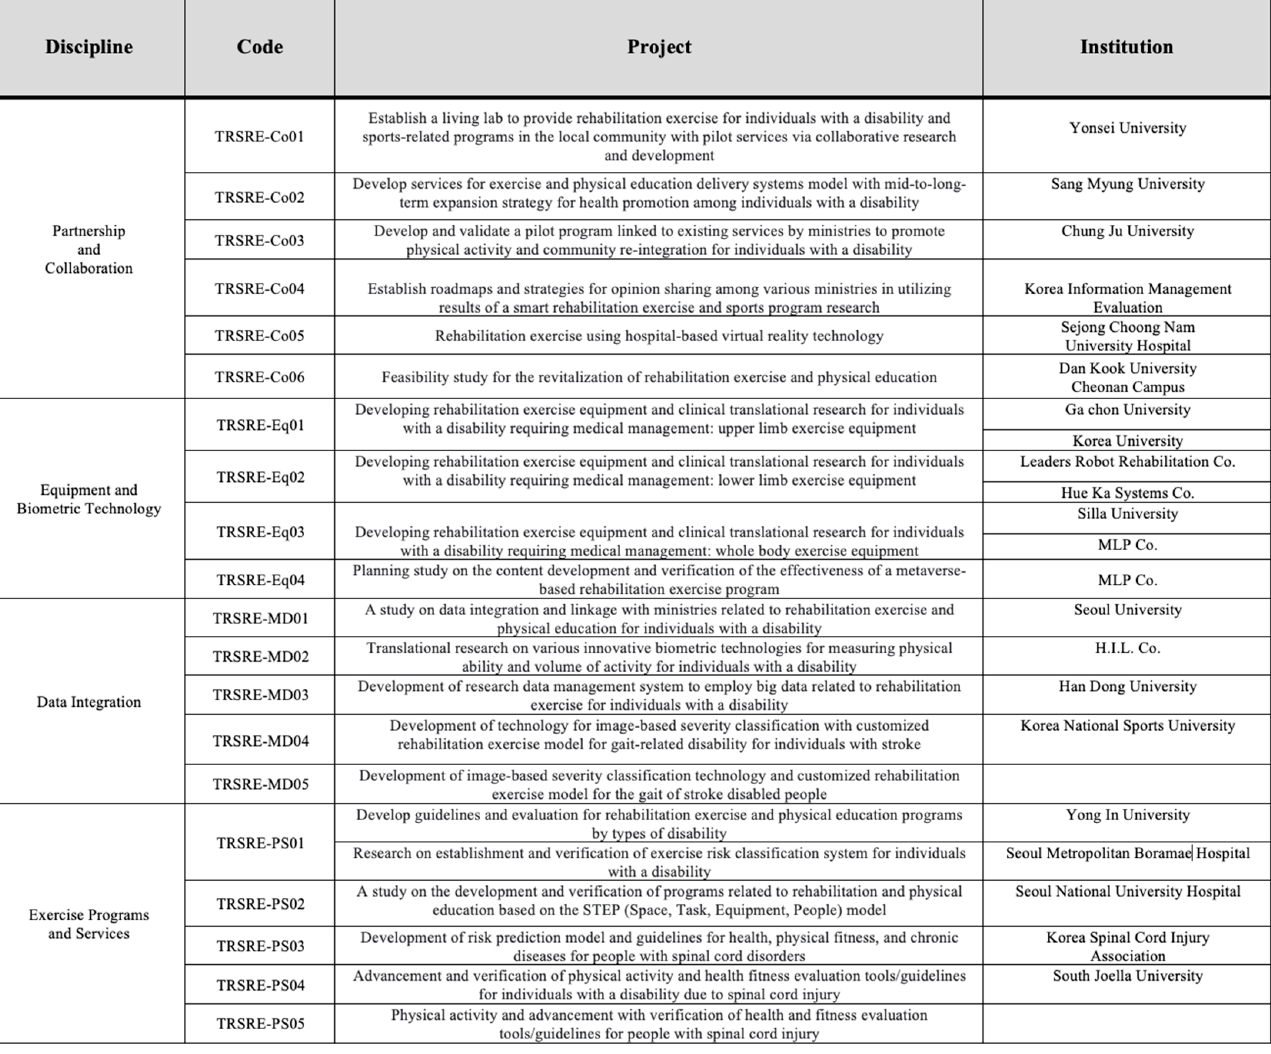
Figure 2. The four disciplines in rehabilitation exercise and sports translational research and development are subdivided into various projects delegated to academic and corporate institutions as part of the federally funded R&D project.